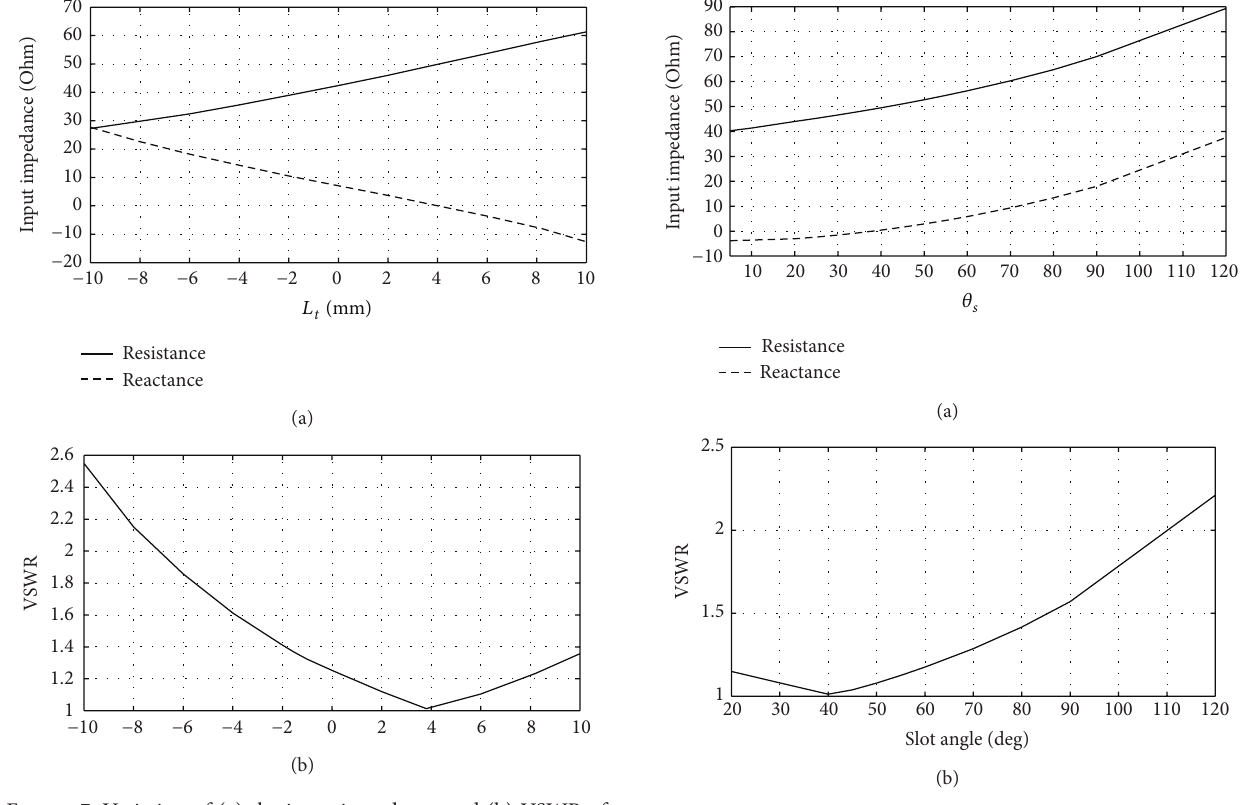
Figure 7: Variation of (a) the input impedance and (b) VSWR of Figure 8: Variation of (a) the input impedance and (b) VSWR of a split coaxial balun excited at the coaxial line side and terminated a split coaxial balun excited at the coaxial line side and terminated at the split line side by a balanced 75 Ω load with the length of the at the split line side by 75 Ω -load with the slot angle; 𝑓 = 2.0 GHz, = 8 mm, 𝐷 = 3.5 mm, transitional section, 𝐿 𝑡 ; 𝑓 = 2.0 GHz, 𝐷 = 8 mm, 𝐷 = 3.5 mm, 𝐷 = 4.8 mm, 𝐿 = 6.72 cm, 𝐷 1 in out 1 in 2 in 1 out = 2.4 mm, 𝐿 = 6.34 cm, 𝐿 = 3.82 cm, and 𝜃 = 40 ∘ . 𝐷 out = 3.44 cm, 𝐿 = 6.34 cm, 𝐿 = 3.82 cm, and 𝐿 = 3.8 𝐿 2 in 1 in 2 in 𝑠 2 out 1 in 2 in 𝑡